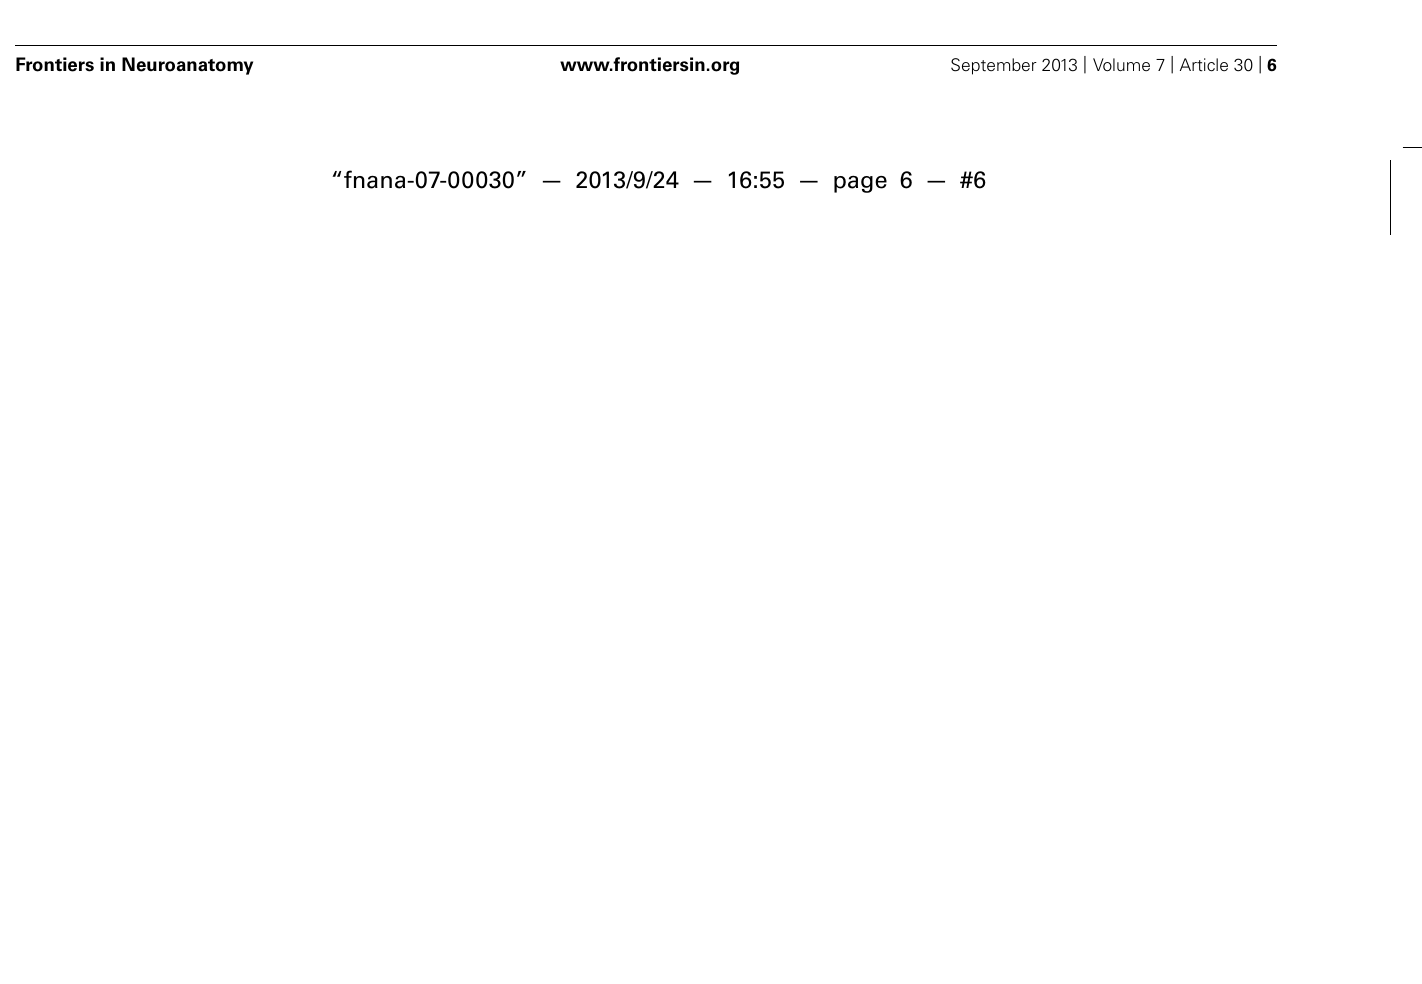
the smallest in preclinical AD (870 ± 93 μ m 2 ). In human cases, the mean number of dystrophic NF + neurites correlated with A β plaque size in both preclinical ( Figure 6A , r = 0.46, p < 0.001, t -test) and end-stage AD ( Figure 6B , r = 0.82, p < 0.001, t -test) cases. There was a similar pattern in the transgenic mice, with higher numbers of NF + DNs associated with larger plaques in APP/PS1 ( Figure 6C , r = 0.72, p < 0.001, t -test; mean plaque size = 1072 ± 67 μ m 2 ) and Tg2576 ( Figure 6D , r = 0.39, p < 0.01, t -test; mean plaque size = 882 ± 118 μ m 2 )